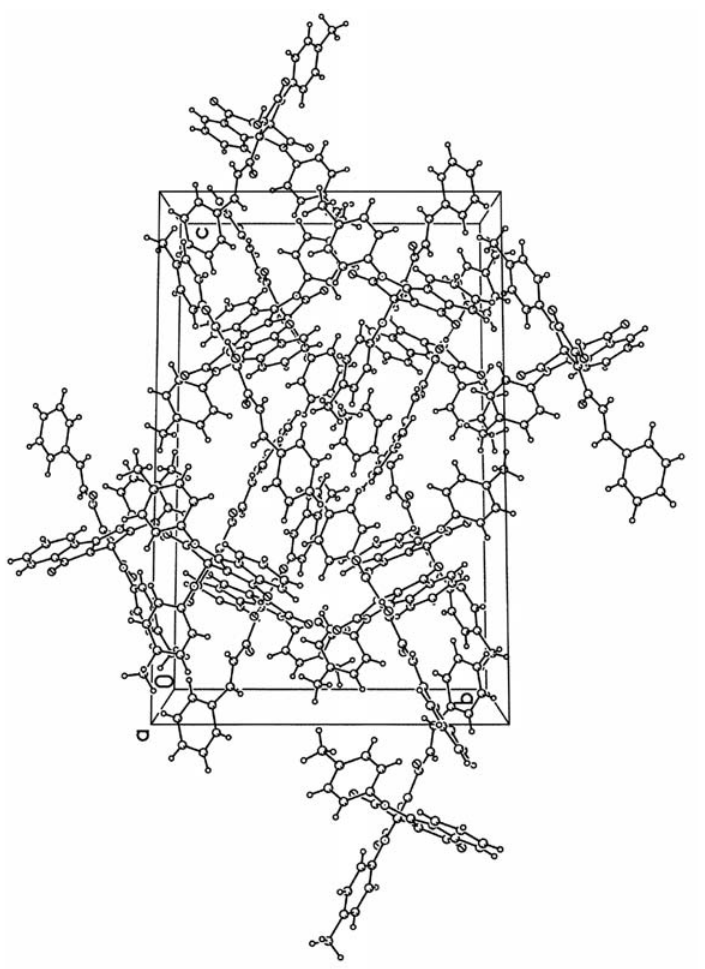
Figure 2. The figure of crystal packing of the compound 3c